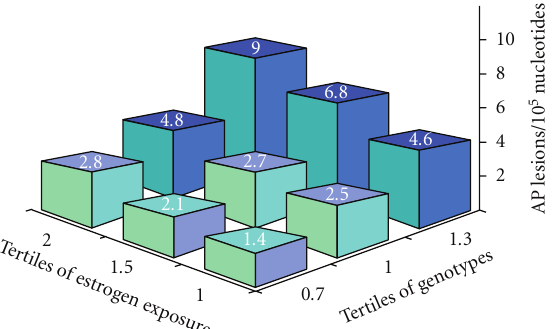
Figure 5: Three-dimensional graph displaying the interaction of estrogen exposure, enzyme genotypes, and resulting AP sites per 10 5 nucleotides. We display estrogen exposure in tertiles on the x -axis. Estrogen exposure can be represented by actual E 2 values, measured in pmol/L, in combination with semiquantitative estimates of each woman’s overall exposure to estrogen. The latter can be derived by taking into account her total years of ovulation as a function of current age, age at menarche, age at menopause, numbers of full-term pregnancies, and the dosage and duration of the use of exogenous estrogens. Thus, as far as the model is concerned, exogenous and endogenous estrogens can be combined although their precise contribution to estrogen exposure is presently unknown. The y -axis represents the combined e ff ects of wild- type and variant enzyme haplotypes in the oxidative estrogen metabolism and BER pathways on AP levels. In theory, all enzyme genotype combinations shown in Figures 4(b) and 4(c) could be plotted. However for clarity, we have plotted only the wild-type and the lowest and highest variant haplotypes, separated into tertiles based on their respective AP sites per 10 5 nucleotides, which is represented on the z -axis. (The authors acknowledge Eric Parl for the design of this